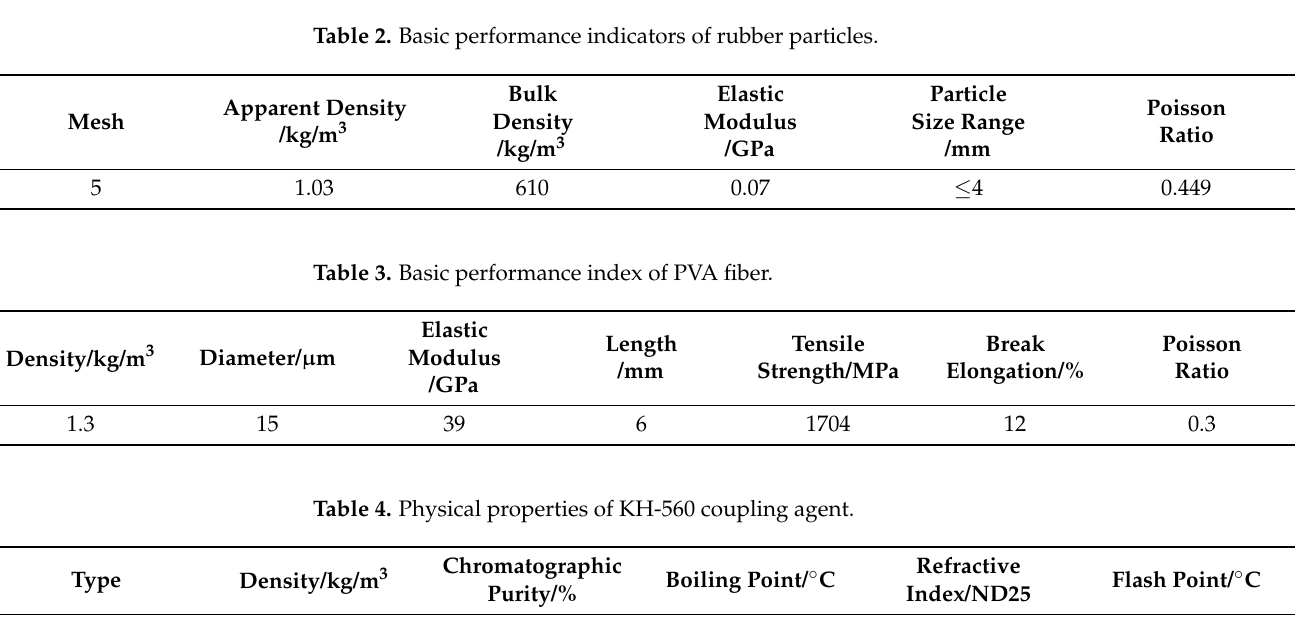
Table 5, the mixing ratio for six groups of PVA fiber rubber concrete is